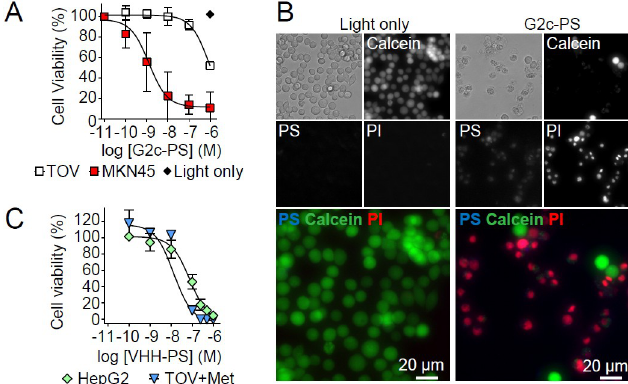
Figure 6. Met-targeting G2c-PS induce cell death of Met-expressing cells upon activation by illumination. ( A ) Selective killing of Met-overexpressing MKN45 tumor cells and not of Met-negative TOV112D cells by G2c-targeted PDT. Cells were pulsed for 2 h at 37 °C and subsequently illuminated to activate the PS. Cell viability was assessed one day later. Mean ± SD of n = 3 is shown. ( B ) Phase contrast and fluorescence microscopy (EVXOS) of PDT-treated MKN45 cells showing G2c-PS (blue in merge, visible as magenta (red + blue)), live cells (calcein, green), and dead cells (propidium iodide, red). ( C ) Induction of cell death of Met-expressing TOV + Met and HepG2 cells by G2c-PS upon a 2 h pulse followed by PS activation via illumination. Representative plot of n = 2.